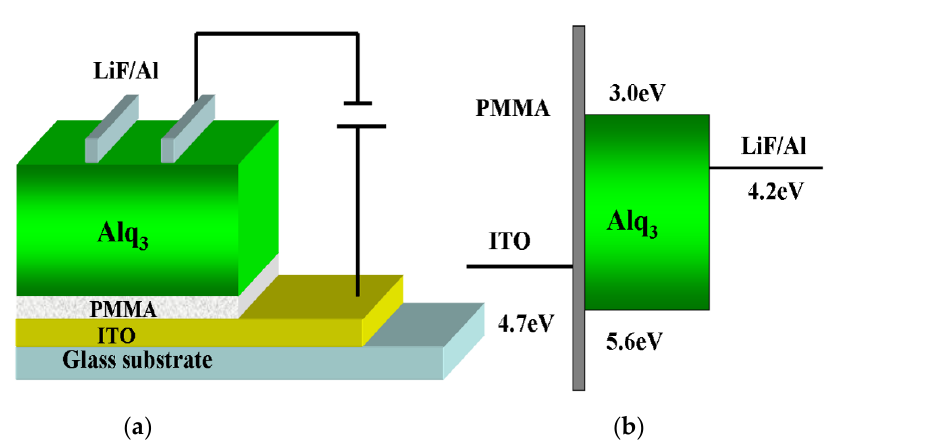
Figure 1. ( a ) Device structure of the OLEDs ( b ) Energy level diagram of the OLEDs [44].